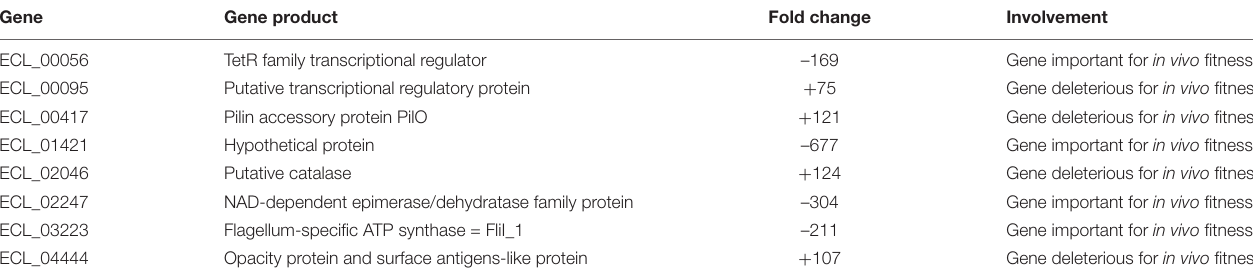
TABLE 3 | Genes selected for specific